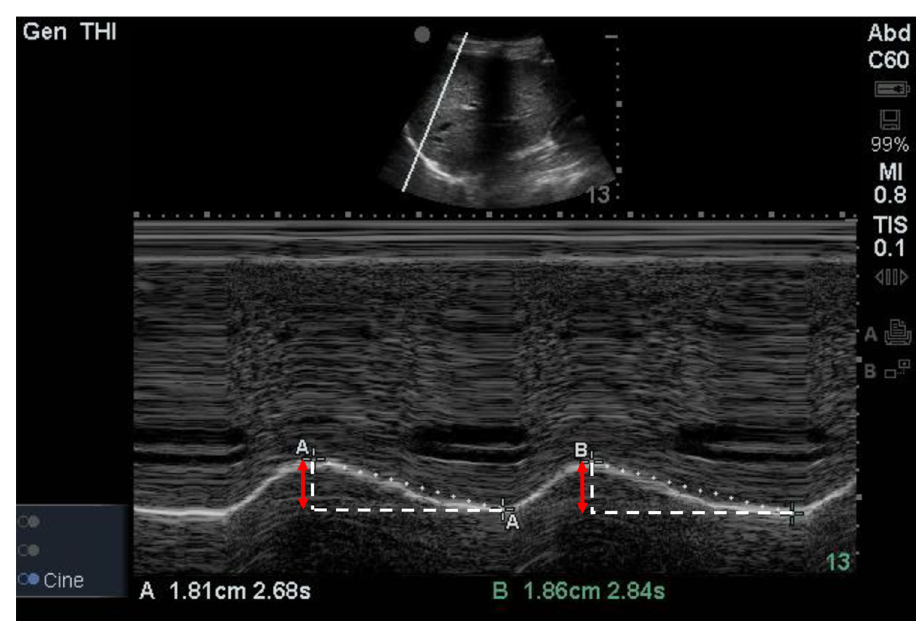
Fig 2. M-mode sonography of diaphragmatic excursion. The amplitude of excursion (red arrow) was measured on the vertical axis of the tracing from the baseline to the point of maximum height of inspiration.